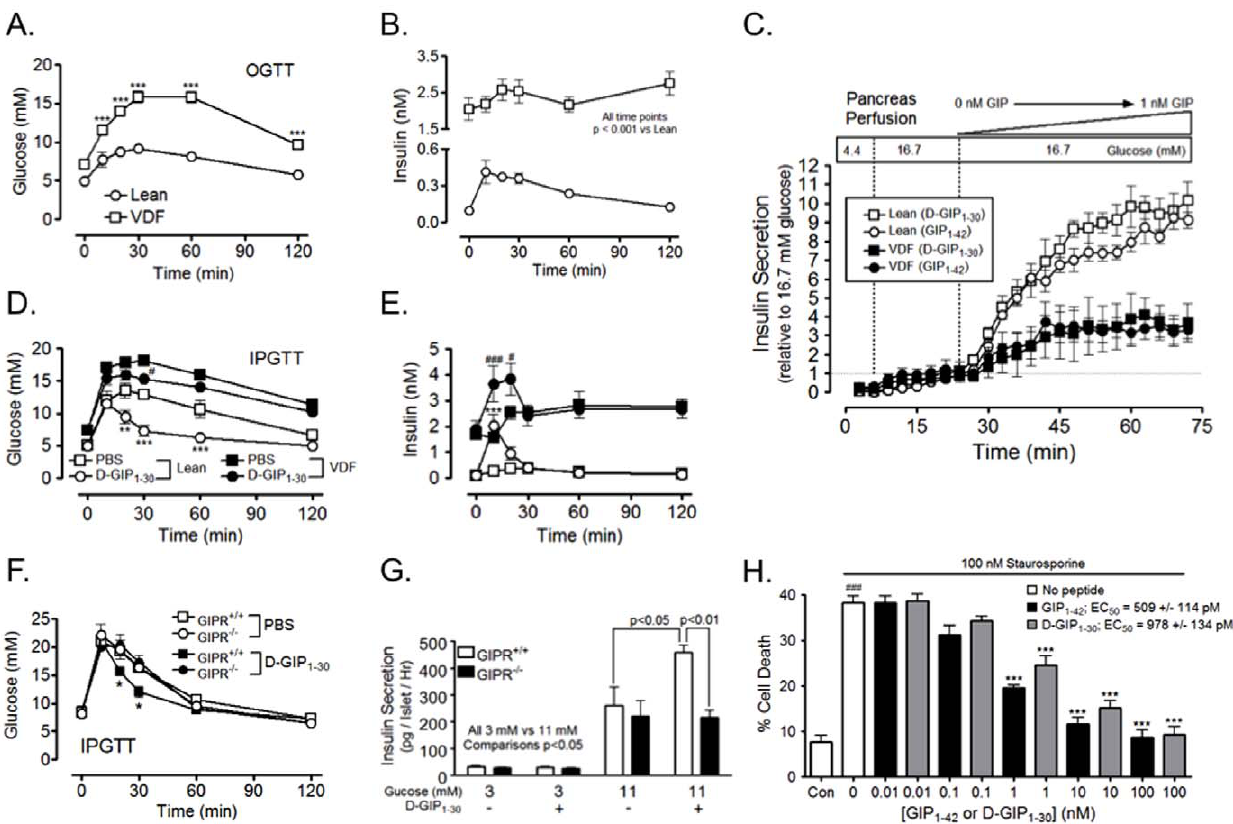
Figure 1. A DPP-IV resistant GIP analog (D-GIP 1–30 ) demonstrates equivalent islet actions to GIP 1–42 . A , OGTTs were performed on fasted Lean (n=3) and obese VDF (n=6) rats and blood glucose levels measured. Mean 6 SEM; ***, p , 0.001 vs Lean rats. B , Insulin levels were determined from blood samples collected in A . Mean 6 SEM with significance as indicated. C , Pancreas perfusions with 16.7 mM glucose + D-GIP 1–30 or GIP 1–42 (0–1 nM) were performed on Lean and obese VDF rats and insulin levels determined in perfusate. Mean 6 SEM (n=3). D , i.p. glucose tolerance tests (IPGTT) were performed on fasted Lean (n=3) and obese VDF (n=4) rats that received the glucose immediately following s.c. injections with PBS or D-GIP 1–30 (8 nmol/kg BW) and blood glucose levels measured. Mean 6 SEM; **, p , 0.01, ***, p , 0.001 vs Lean controls; # , p , 0.05 vs VDF controls. E , Insulin levels were determined from blood samples collected in D . Mean 6 SEM; ***, p , 0.001 vs Lean controls; # , p , 0.05, ### , p , 0.001 vs VDF controls. F , IPGTTs were performed on fasted wild type (GIPR + / + ) mice and GIPR knockout (GIPR 2 / 2 ) mice that received the glucose immediately following s.c. injections with PBS or D-GIP 1–30 (8 nmol/kg BW), and blood glucose levels measured. Mean 6 SEM (n=3); *, p , 0.05 vs GIPR + / + mice treated with PBS. G , Islets from GIPR + / + and GIPR 2 / 2 mice were incubated for 2 h in 3 or 11 mM glucose 6 10 nM D-GIP 1–30 and secreted insulin levels determined. Mean 6 SEM (n=3); significance as indicated. H , INS-1 cells were treated without or with 100 nM staurosporine + increasing concentrations of D-GIP 1–30 or GIP 1–42 (0–100 nM) for 6 h and cell death determined. Mean 6 SEM (n=4); ### , p , 0.001 vs control (no staurosporine); ***, p , 0.001 vs staurosporine alone. In the upper right is the calculated EC 50 value for GIP 1–42 and D-GIP 1–30